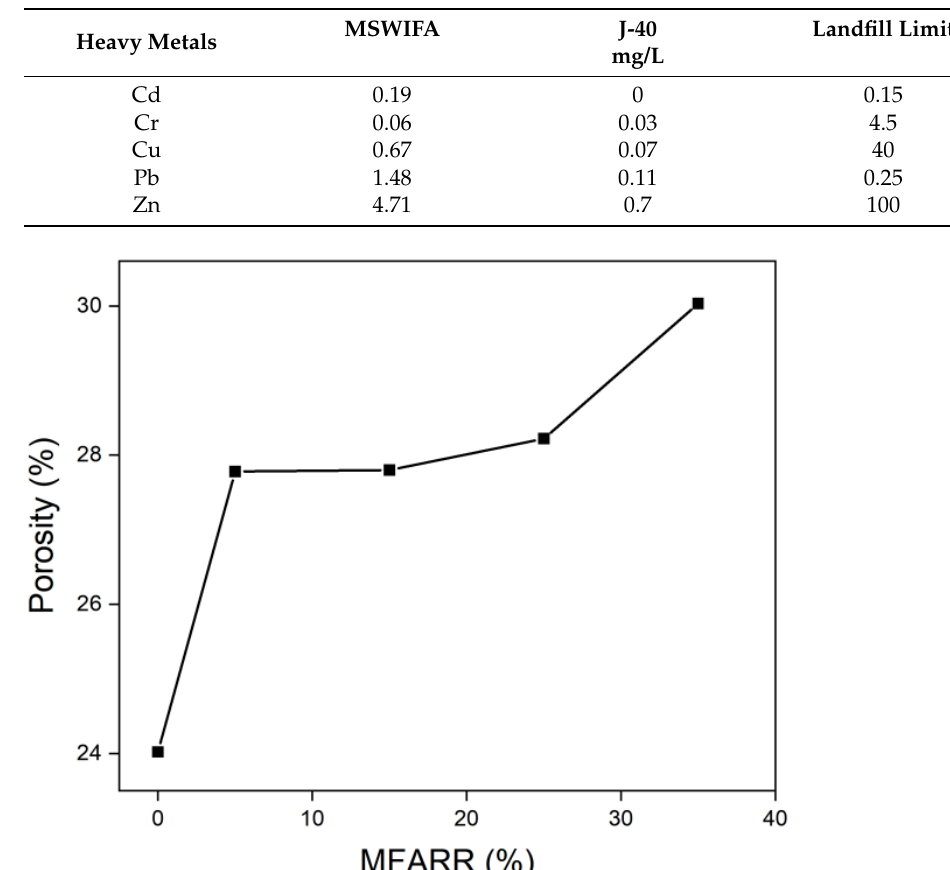
Table 3. Pore diameter distribution of the geopolymer mortar. Table 4. Heavy metal leaching results and landfill limits.